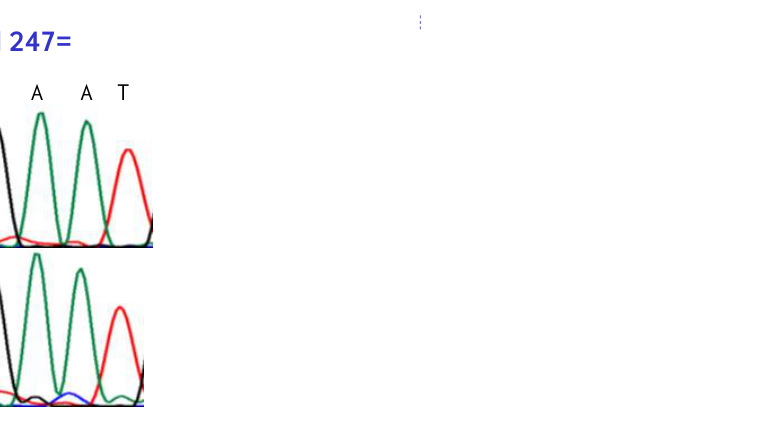
Figure 6. Allelic variants of the human LHX9 (NM_020204.3) gene located on the long arm of chromosome 1. Five exons (blue boxes) were assessed by PCR-SSCP analysis and the coding/non- coding variants were identified by DNA sequencing. The locations of the substitutions are indicated above the electropherogram.